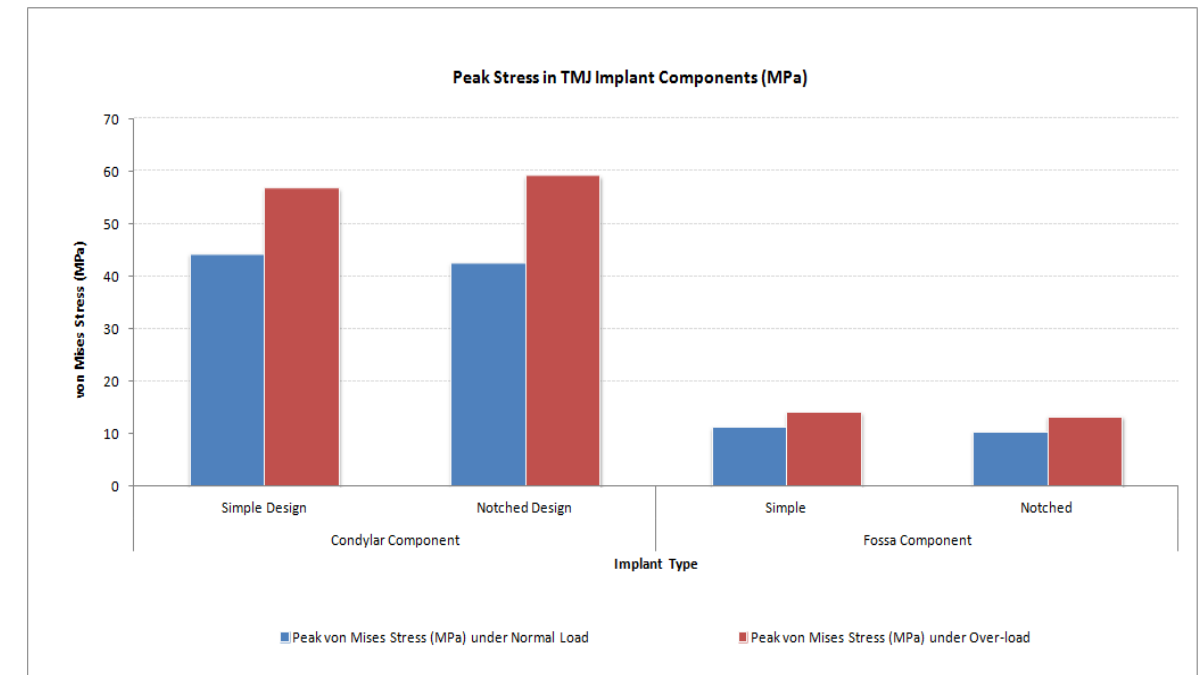
Figure 35. Peak von Mises stress in condylar/ramus and fossa components of patient-specific total TMJ prostheses during FE simulations under normal and worst-case/over-load configurations.